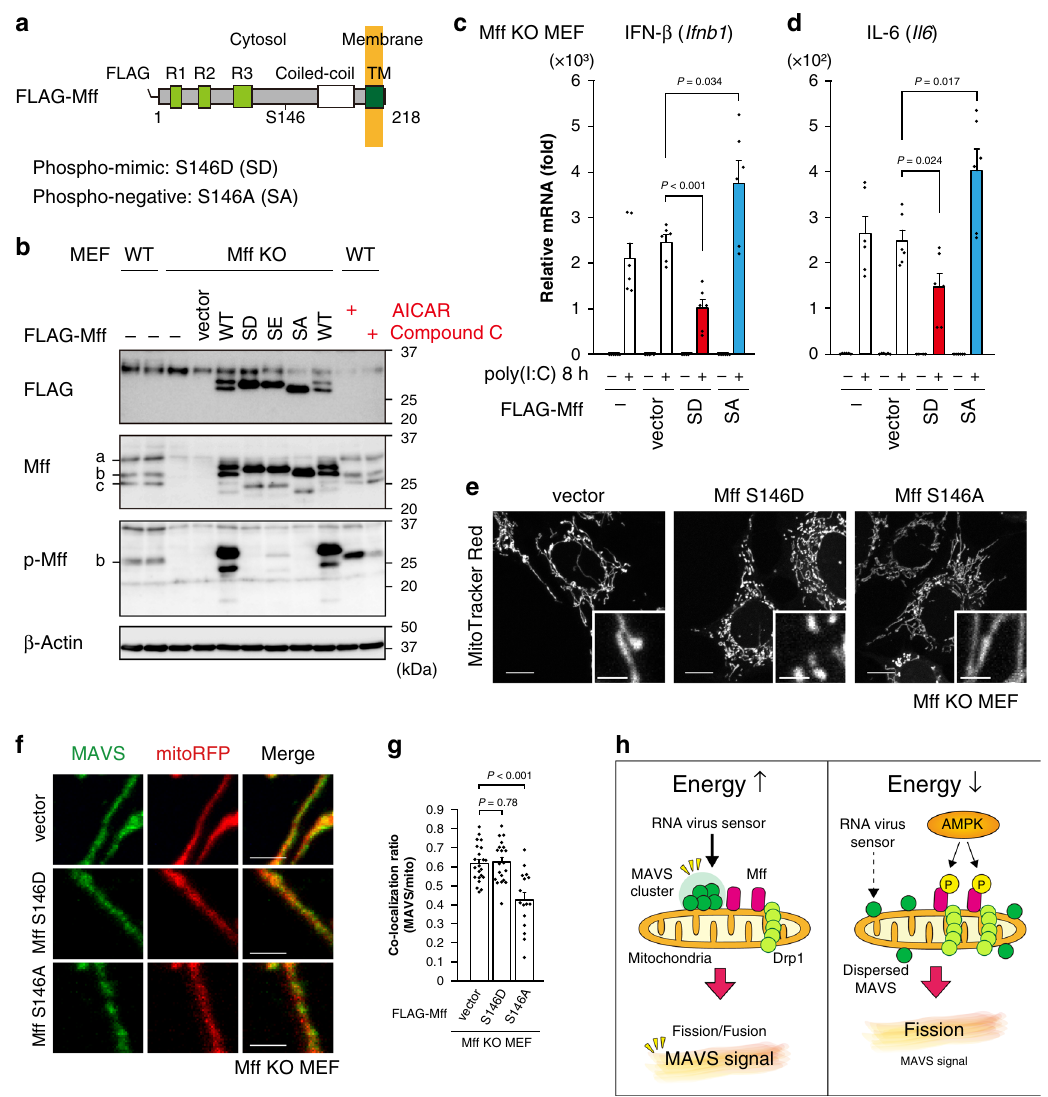
Fig. 5 Mff phosphorylation impairs mitochondrial antiviral response. a Scheme of the murine phosphorylation-negative/mimic Mff constructs used in this study. A point mutation was introduced into FLAG-tagged Mff (WT) at S146 as indicated. b Mff KO MEFs stably expressing each Mff construct were analyzed by immunoblotting using anti-FLAG, anti-Mff, and anti-phospho-Mff antibodies. SD: S146D, SE: S146E, SA: S146A. WT MEFs treated with AICAR (AMPK activator: 2 mM) or compound C (AMPK inhibitor: 20 μ M) for 2 h were used as controls. c , d qRT-PCR of IFN- β ( c ) and IL-6 ( d ) mRNA in Mff KO MEFs stably expressing each Mff construct with or without poly(I:C)-LMW (1 μ g/mL) transfection for 8 h. Data represent means ± SEM of three independent experiments ( n = 6, P values; two-tailed unpaired t test). e Representative live-cell images of MitoTracker Red (mitochondria, white) in Mff KO MEFs stably expressing each Mff construct. Scale bars: 10 μ m (whole) and 2 μ m (inset). f Magni fi ed images of MAVS on mitochondria in Mff KO MEFs stably expressing each Mff construct. The cells were transiently transfected with a mitochondrial marker mitoRFP (red) and immunostained with an anti- MAVS antibody (green). Scale bars: 2 μ m. g Co-localization ratio between MAVS and mitoRFP in Mff KO MEFs stably expressing each Mff construct. Data represent means± SEM (vector, SD, SA: n = 22, 20, 16, P values; two-tailed unpaired t test). h Working hypothesis for the energetic regulation of the mitochondrial antiviral response by Mff phosphorylation. Immunoblot analyses and all microscopic analyses were repeated independently more than three times with similar results. Source data are provided as a Source data fi cells (Fig. 3c). Stably expressed Mff (WT) was excessively phos- phorylated at S146 (Fig. 5b), which should cause impaired anti- viral response, although the molecular details remain unknown.